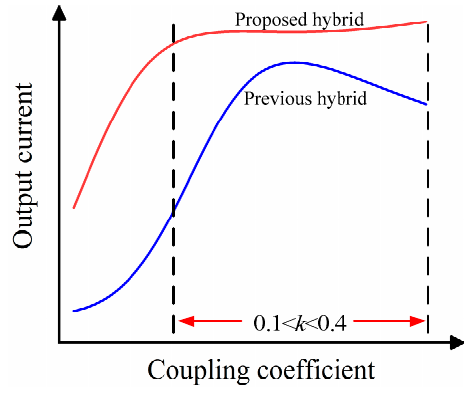
Figure 1. Comparison of the different topologies.